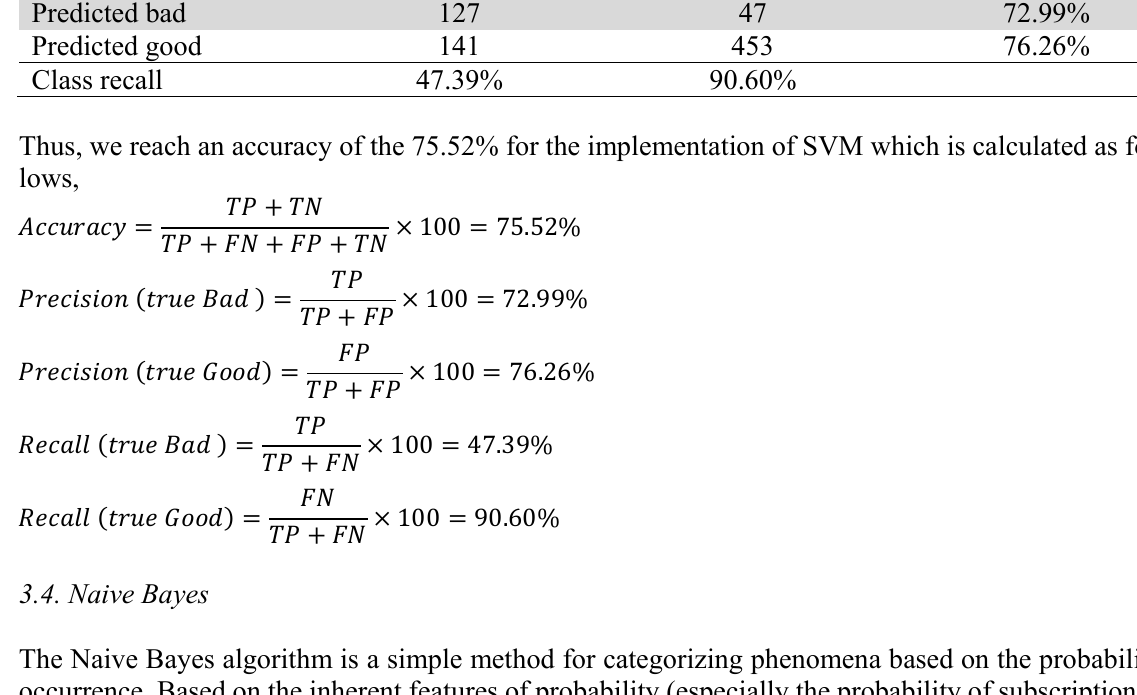
The results of the implementation of SVM Truly bad Truly good Class precision Predicted bad 127 72.99% Predicted good 141 Class recall 47.39%